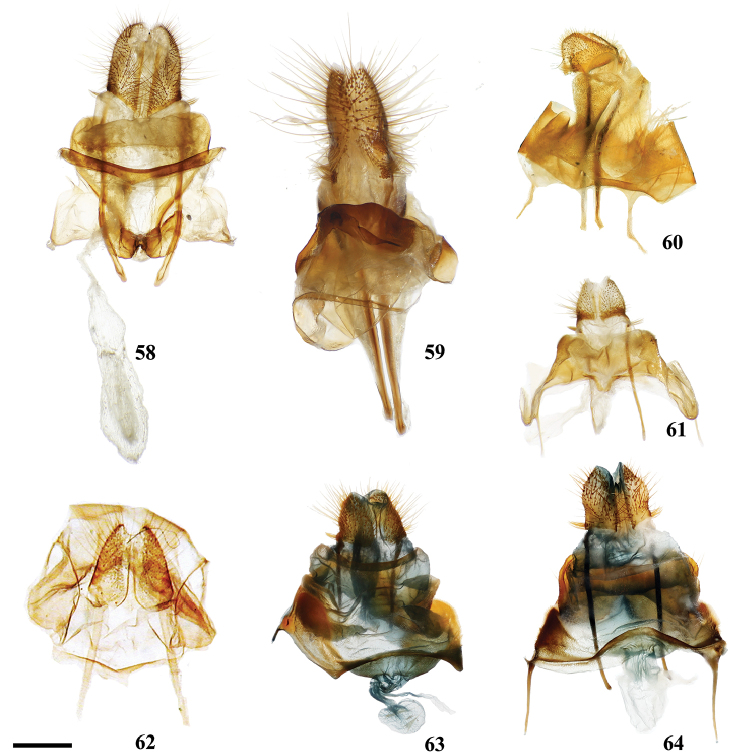
Ventral view of female genitalia of type species (except where noted) of genera belonging to Druenticinae. 58Druenticapartha, St Laurent diss.: 3-31-18:5 (MGCL) 59Procinnuscfacuta, St Laurent diss.: LEP50136, not the type species of Procinnus (MGCL) 60Micrallominutus, St Laurent diss.: 10-21-15:2 [reused with permission from St Laurent and Mielke (2016), ZooKeys] (USNM) 61Ulalumavalva, St Laurent diss.: 10-10-17:2 [reused with permission from St Laurent et al. (2018a), Systematic Entomology] (MJWC) 62Pamea sp., Franclemont diss.: 1766, genitalia not to scale (CUIC) 63Luramaquindiuna, St Laurent diss.: 4-14-16:1, not the type species of Lurama [reused with permission from St Laurent (2016), ZooKeys] (USNM) 64Ulmaraconjuncta, St Laurent diss.: 4-19-16:1 [reused with permission from St Laurent (2016), ZooKeys] (MWM). Scale bar: 1 mm.